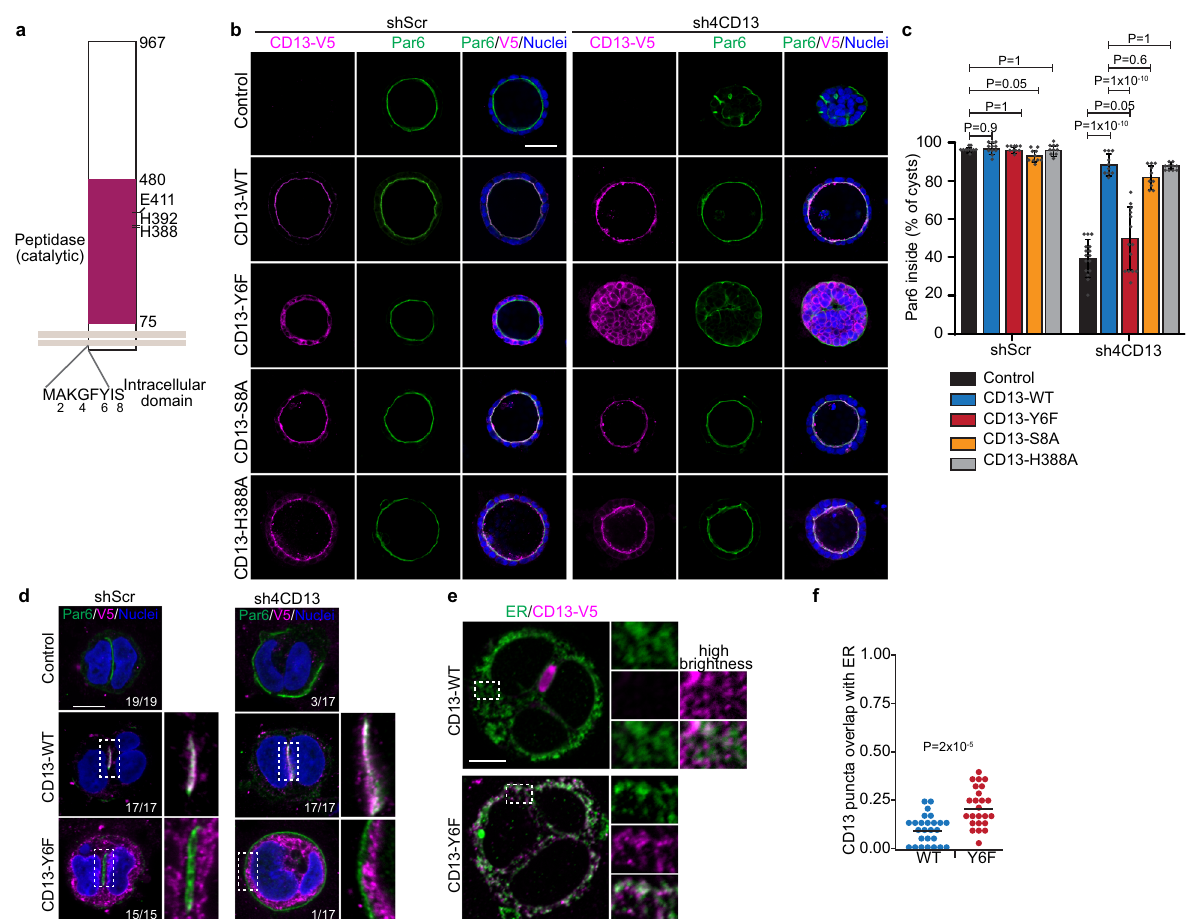
Fig. 7 The intracellular domain of CD13 is required to maintain apical-basal polarity. a Schematic diagram showing mutation sites at intracellular and peptidase domain of CD13. b Confocal images of CD13-V5 (magenta) and Par6 (green) showing the rescue phenotype in wildtype and different CD13 mutants of shScr and shCD13 Caco-2 cysts. c Quanti fi cation of the percentage of Caco-2 spheroids with internally localized Par6 in wildtype (shScr, n = 515; shCD13, n = 292), CD13-Y6F (shScr, n = 462; shCD13, n = 433), CD13-S8A (shScr, n = 541; shCD13, n = 333), and CD13-H388A (shScr, n = 452; shCD13, n = 336) of shScr ( n = 428) and shCD13 ( n = 492) Caco-2 cysts. Dots represent mean values± SD from each of 10 experiments. p -values